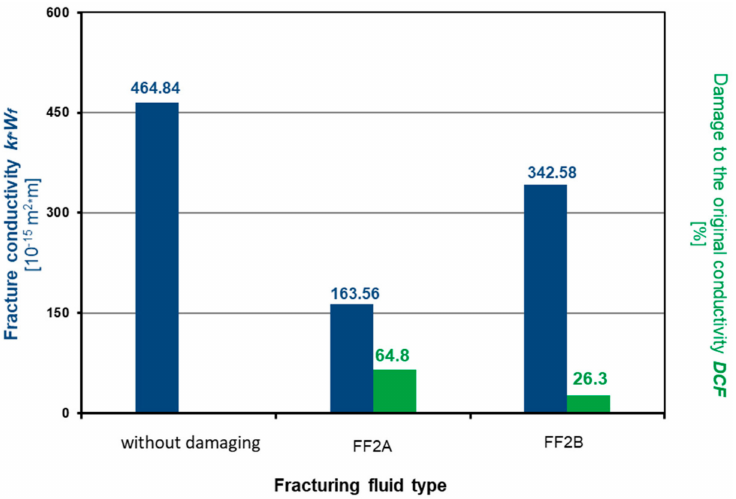
Figure 7. The damage to the primary conductivity of the fracture filled with light ceramic proppant 20/40 done by fracturing fluids FF2A and FF2B at a temperature of 60 ◦ C; compressing stress 41.4